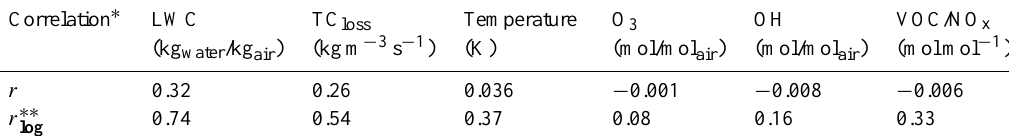
Table 1. Relative importance of factors influencing global spatiotemporal distribution of SOA cld production: correlation between daily SOA cld production rate (P SOAcld ) and each individual factor. Data are paired by space (i.e., horizontal and vertical) and time (daily average).